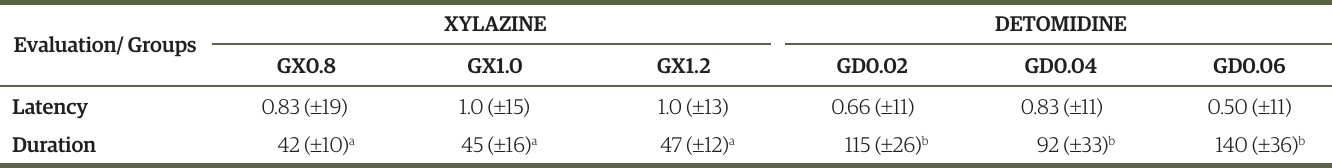
Table 1. Median ( ± Semi-interquartile range) of the latency and duration, in minutes, of the sedative effect produced by detomidine and xylazine, given intravenously in different doses, in donkeys from northeast